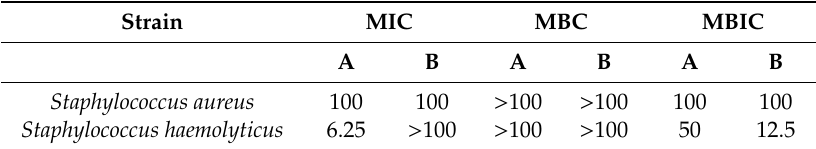
Table 2. Minimum inhibitory concentration (MIC), minumum bactericidal concentration (MBC), and minimum biofilm inhibitory concentration (MBIC) values ( µ g / mL) towards sensitive